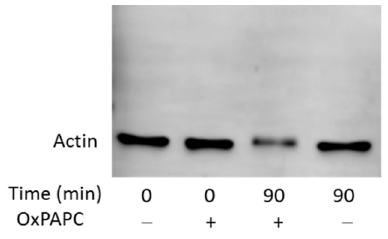
Figure 7. Western blot analysis of β -Actin from the OxPAPC-treated PBS-soluble fraction. The OxPAPC-treated sample incubated for 90 min, shows a decrease of actin immunostaining and a slightly slower band migration. The final OxPAPC concentration was 100 µmol/L.